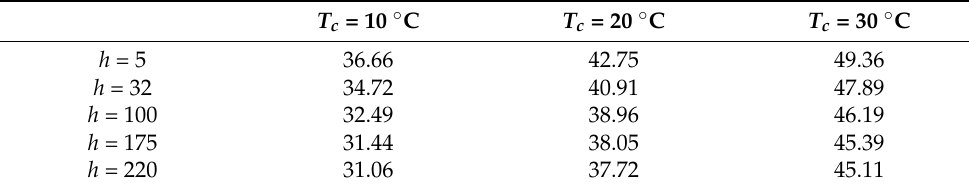
Table 7. Volume-weighted average temperature of pack after discharge ( ◦